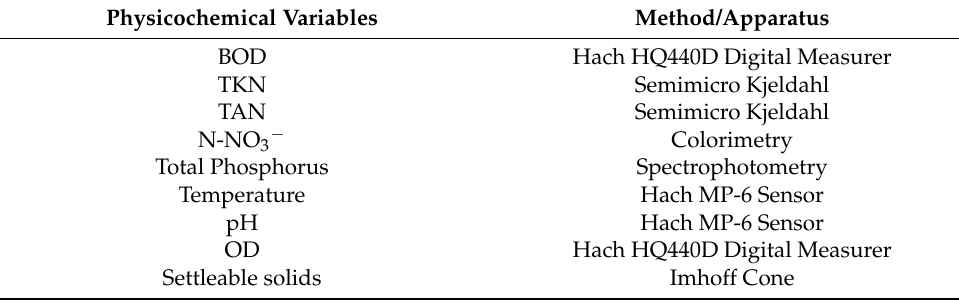
Table 2. Physical-chemical variables, methodology and devices